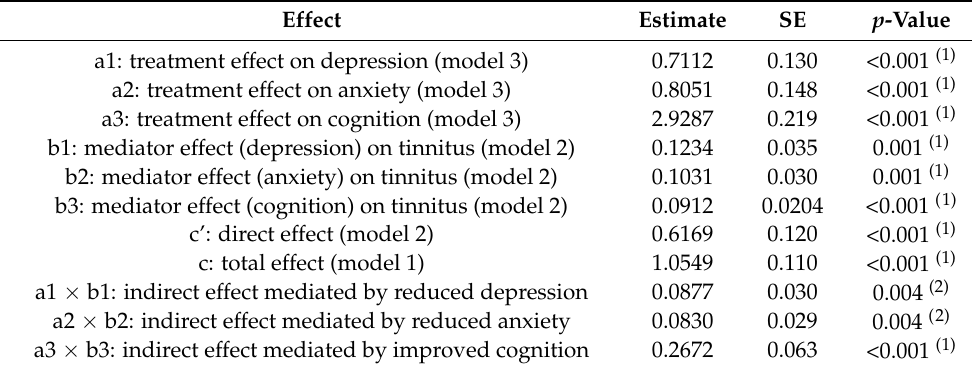
Table 2. Results of the analysis with three mediators based on pooled data from three trials (subset of patients with tinnitus at baseline, n = 594, full analysis set); parameter estimate, standard error (SE) and p -value.